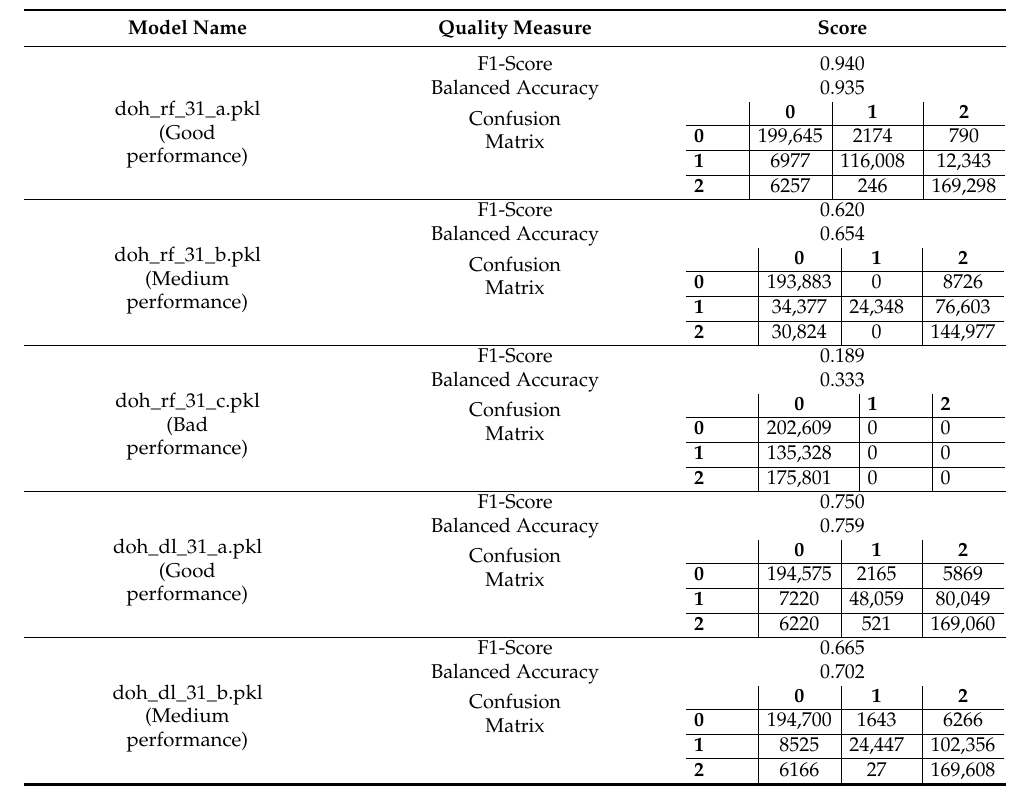
Table 7. Quality measures of DoH traffic classification models. In the confusion matrices 0: NORMAL, 1: DOH, 2: DDOS DOH, where rows represent true values and columns predicted